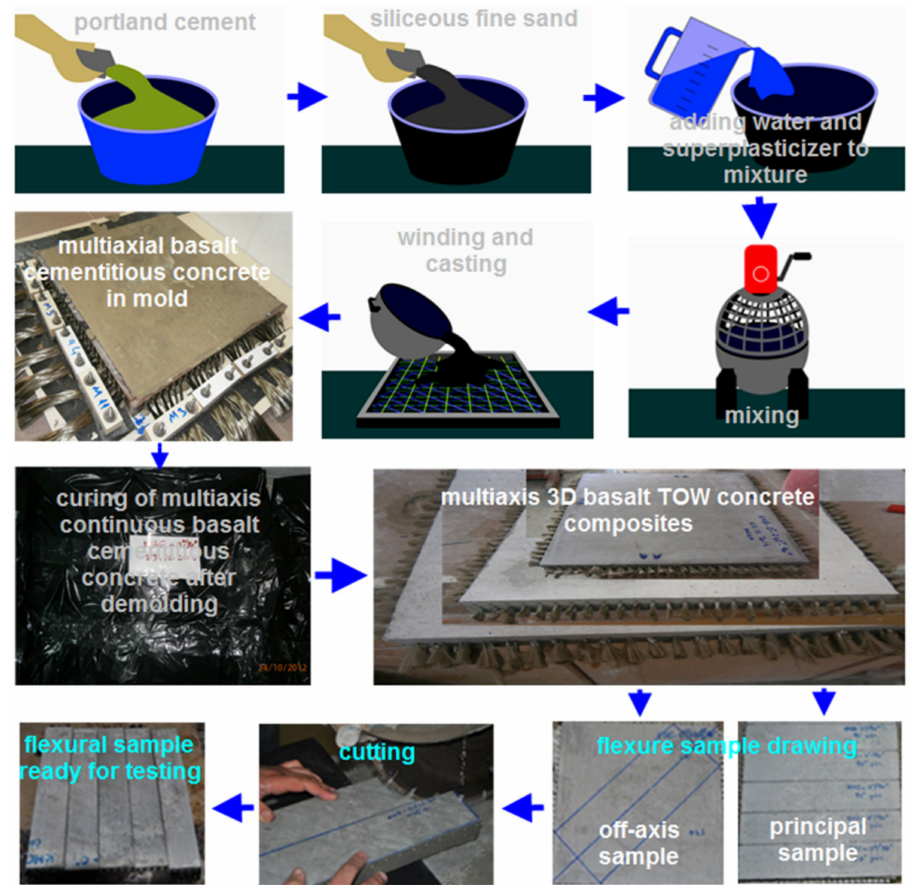
Figure 2. The preparation steps of multiaxis 3D basalt/cementitious concrete, pictorial and schematic